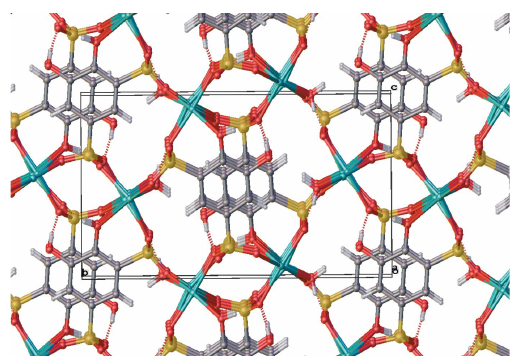
Figure 8 Extended packing diagram of Na 2 (tiron) (cid:2) H 2 O, showing the columnar arrangement of tiron aryl groups and parallel sodium ion